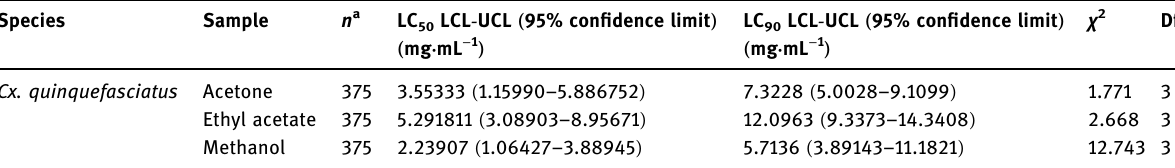
Table 2: Larvicidal activity of C. baccifera leaf extracts against fourth instar larvae of Cx. quinquefasitasis Species Sample